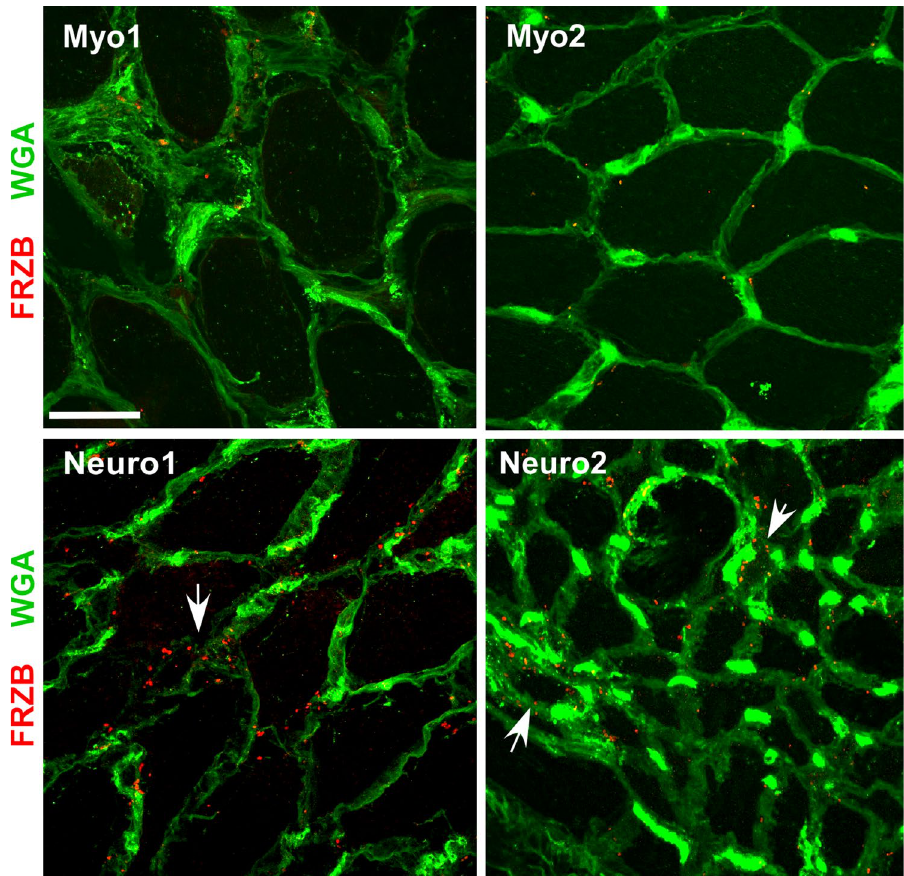
Figure 5. FRZB expression in disease controls. FRZB immunostaining comparing myopathy (Myo1, necrotizing myopathy, vastus lateralis; Myo2, inflammatory myopathy, biceps) and neuropathy (Neuro1, deltoid; and Neuro2, vastus lateralis) disease controls. Some immunostaining of FRZB is seen in the neuropathy controls surrounding myofibers that appear atrophied (arrows). Minimal to no punctate signal is seen in the myopathy samples. Scale bar, 50